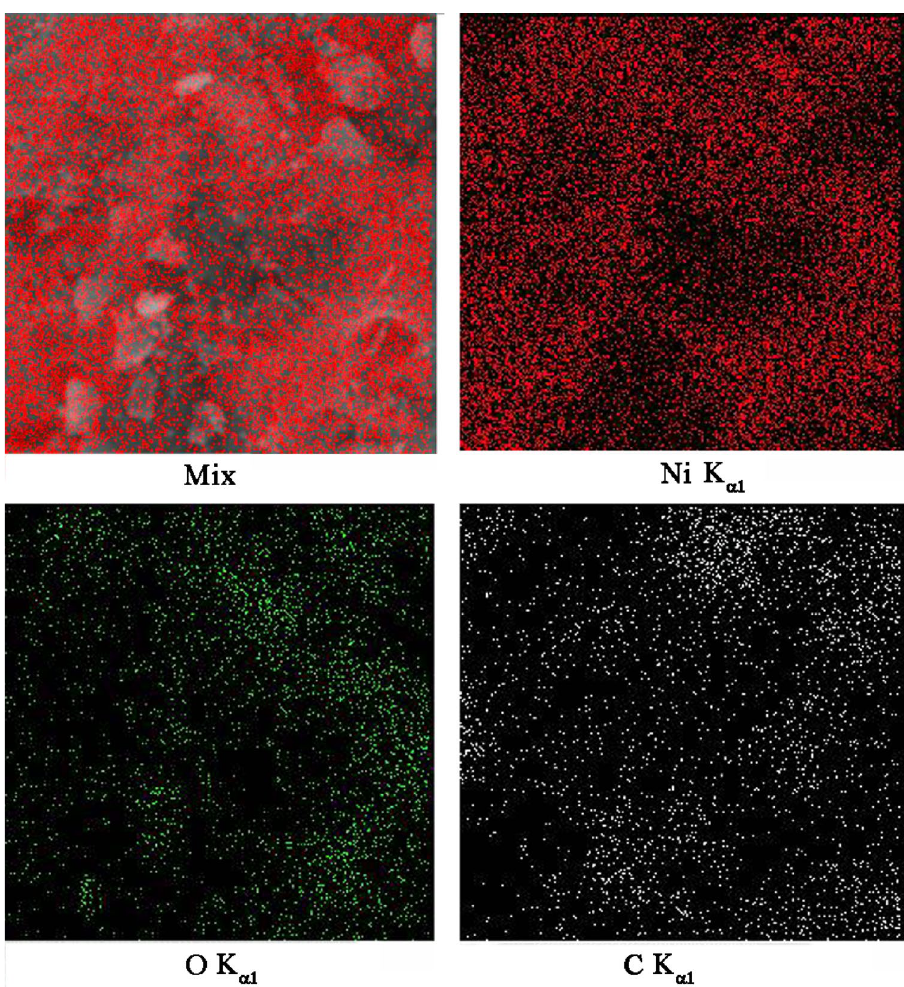
Figure 1. ( A ) MAP analysis image of NiO/SWCNTs